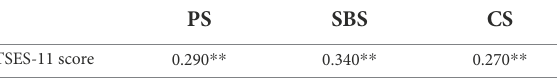
TABLE 7 Multiple linear regression results of PETJSS scores and personal characteristics of physical education